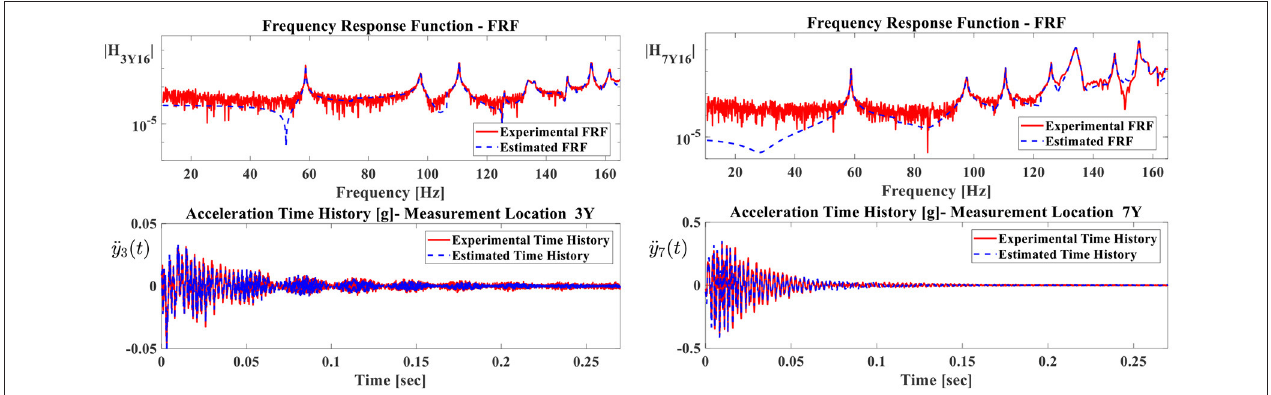
FIGURE 9 | Comparison of FRFs and time histories of accelerations corresponding to frequency response functions | H 3 Y 16 | and | H 7 Y 16 | of accelerometers A3 and A7 at local direction Y.